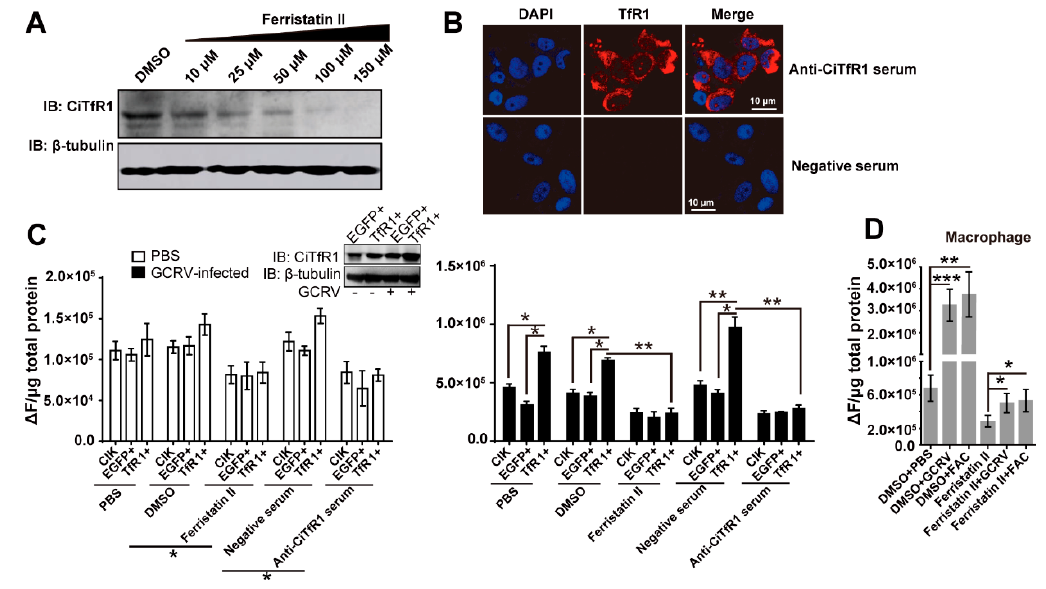
Figure 4. Labile iron pool (LIP) in GCRV-infected CIK cells and macrophages. ( A ) The degradation of Ferristatin II on CiTfR1 . CIK cells were seeded in six-well plates for 24 h cultivation (3 × 10 6 / well), and then the cells were treated with 1 % DMSO or the indicated concentrations of Ferristatin II. Twelve hours later, cells were harvested for WB analysis. ( B ) The verification of CiTfR1 polyclonal antiserum in CIK cells. Confocal images of TfR1 in CIK cells at 12 h after incubation with anti-CiTfR1 polyclonal serum or negative serum. Fixed cells were stained for TfR1 (red) and DAPI (blue). Scale bar = 10 µ m. ( C ) Either TfR1 + , EGFP + , or CIK cells were evenly seeded into 96-well plates for 24-h cultivation (2 × 10 4 / well), and then cells were treated with either 1 % PBS, 1 % DMSO, 100 µ M Ferristatin II, 1% anti-CiTfR1 serum or 1% negative serum. Twelve hours later, all the cultivated cells were infected with GCRV (MOI = 1). Cells were harvested at 12 h postinfection. The intracellular LIP contents were measured by using a Multiscan Spectrum microplate reader. The protein level of CiTfR1 in EGFP + and TfR1 + cells were detected by WB analysis. ( D ) Isolated macrophages were seeded into 12-well plates (5 × 10 5 / well), and then treated with the indicated treatments (concentrations of Ferristatin II and sera were 100 μ M and 1%, respectively; MOI of GCRV is 1). The LIP content of each